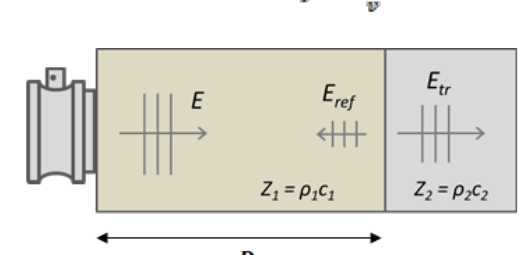
Fig. 1. Reflection of an acoustic wave at the interface between two materials.